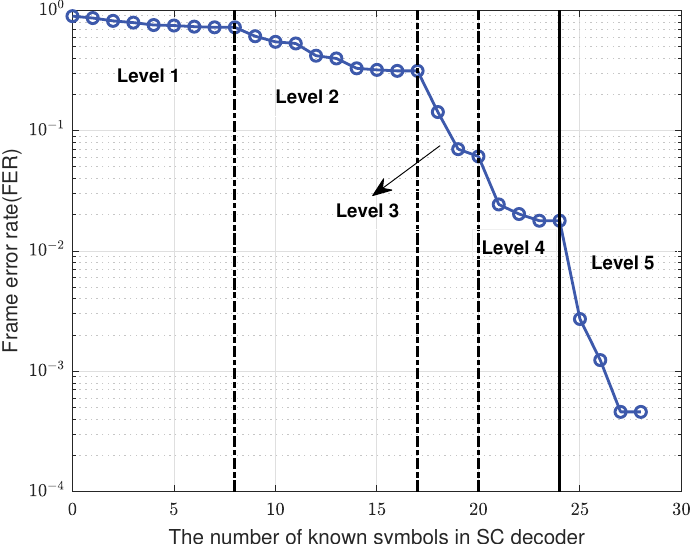
Figure 3. FER over GE channels versus the number of known symbols in a polar codeword, with M = 32 and N =